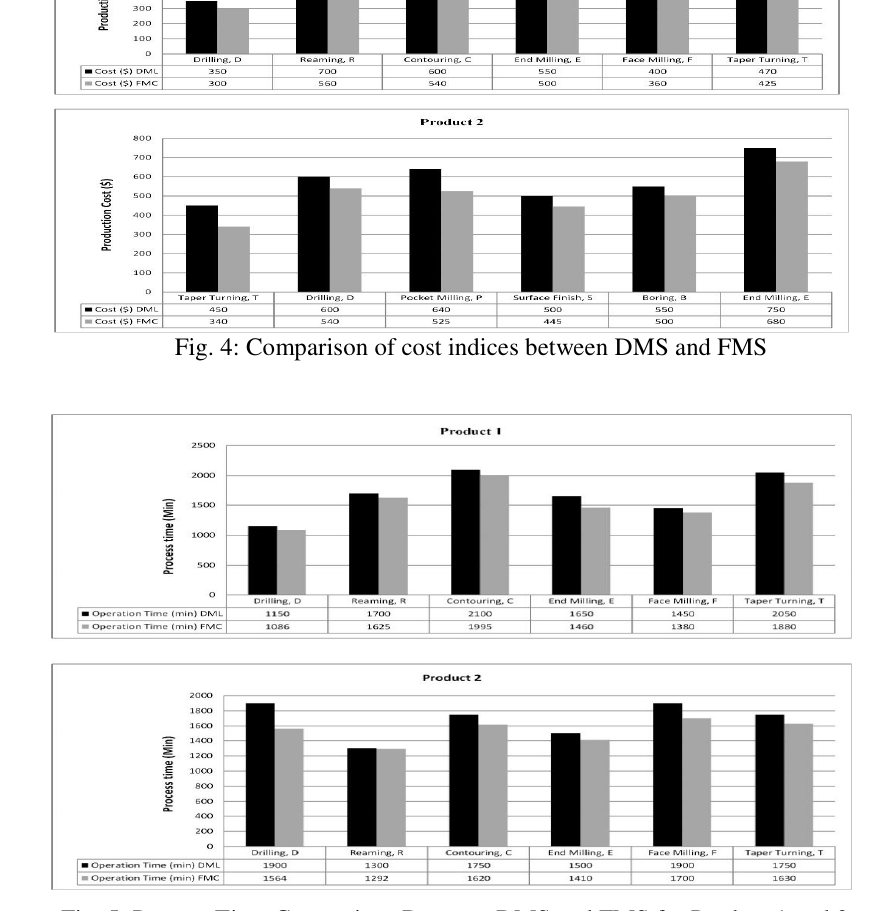
Fig. 5: Process Time Comparison Between DMS and FMS for Product 1 and